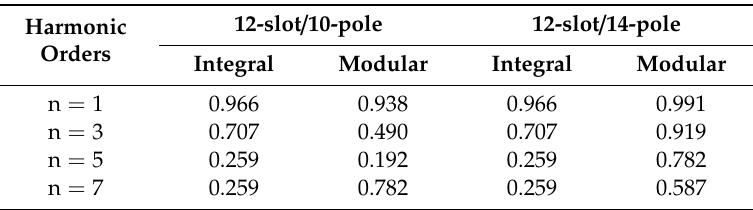
Table 2. Winding factor comparison.